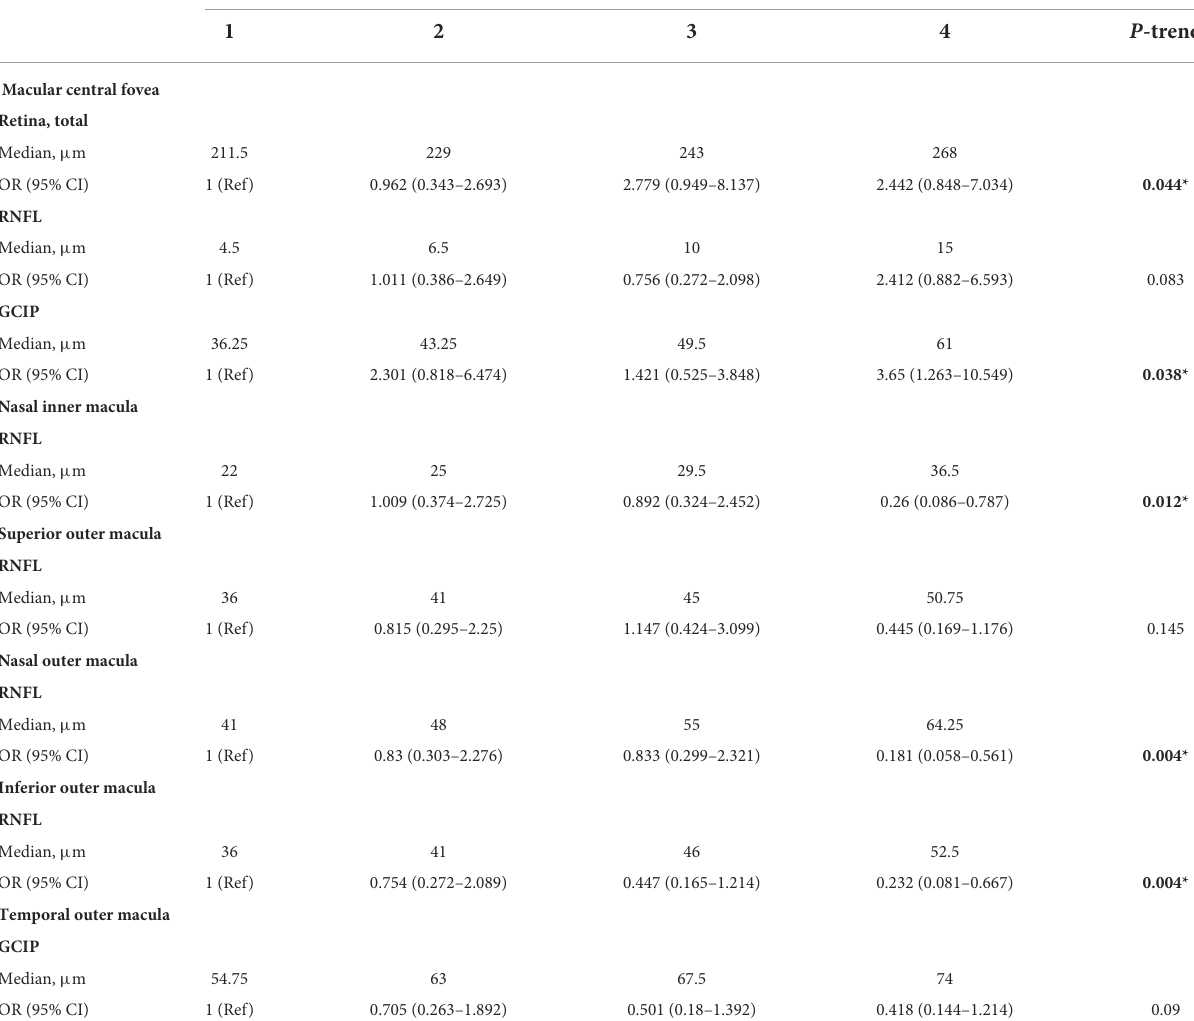
TABLE 4 ORs (and 95% CIs) of higher white matter hyperintensity volume by quartiles of retinal thickness in different